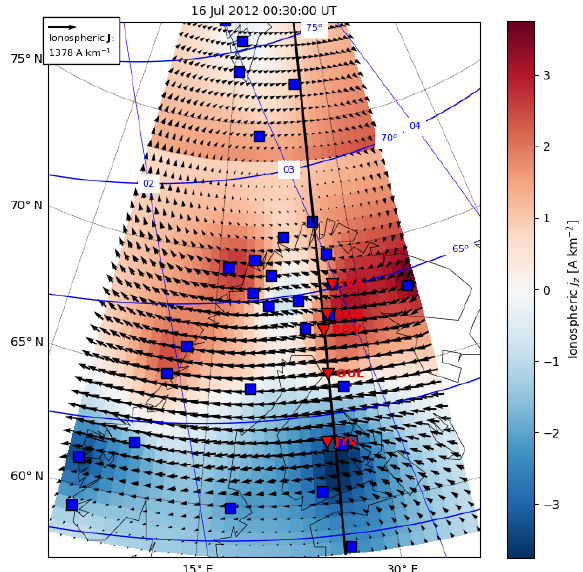
Figure 1. Locations of the riometer stations IVA, SOD, ROV, OUL, and JYV (red) and IMAGE magnetometers (blue). The vectors and colour show the ionospheric equivalent current density and its curl, derived from IMAGE data. The vertical black line marks the lon- gitude along which latitude profiles of the east–west component of the equivalent current density and the curl have been extracted in order to create Fig. 2. The blue grid indicates the magnetic latitudes and magnetic local